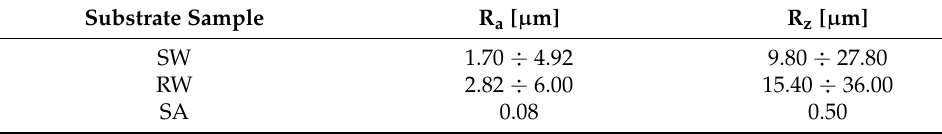
Table 1. Roughness measurements for the three substrate samples. Substrate